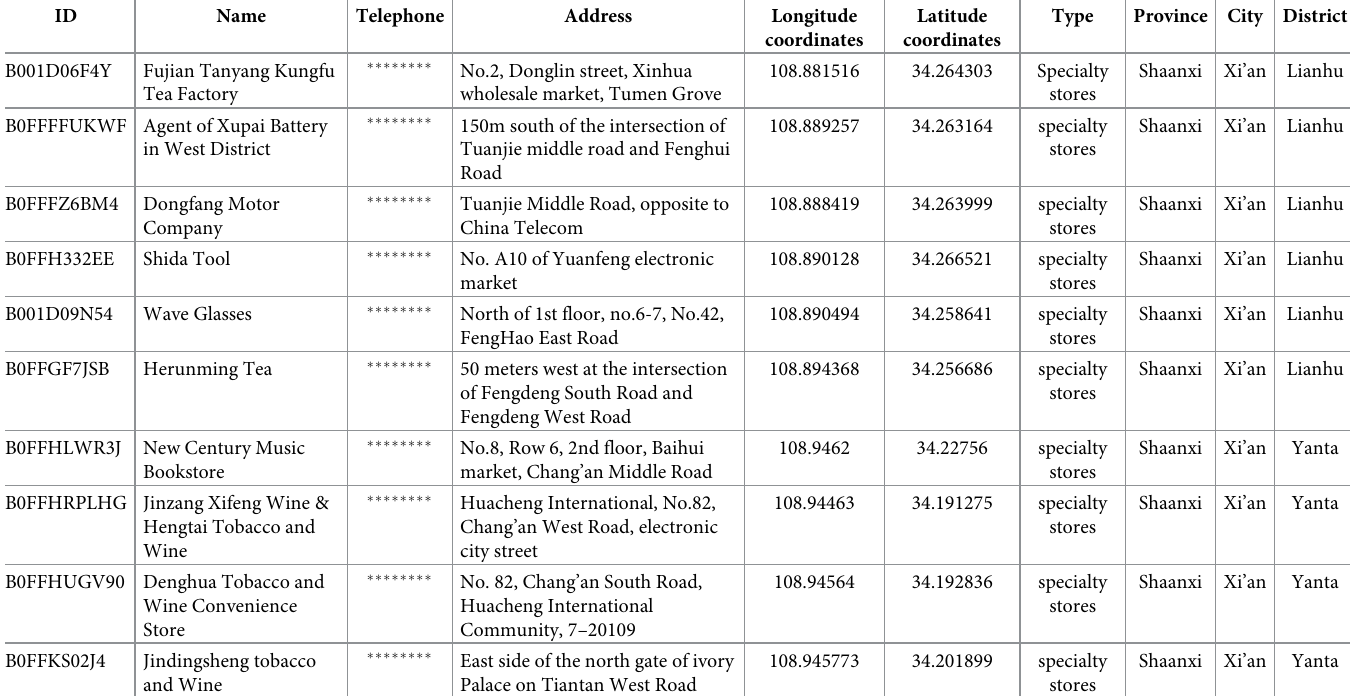
Table 1. POI data structure.